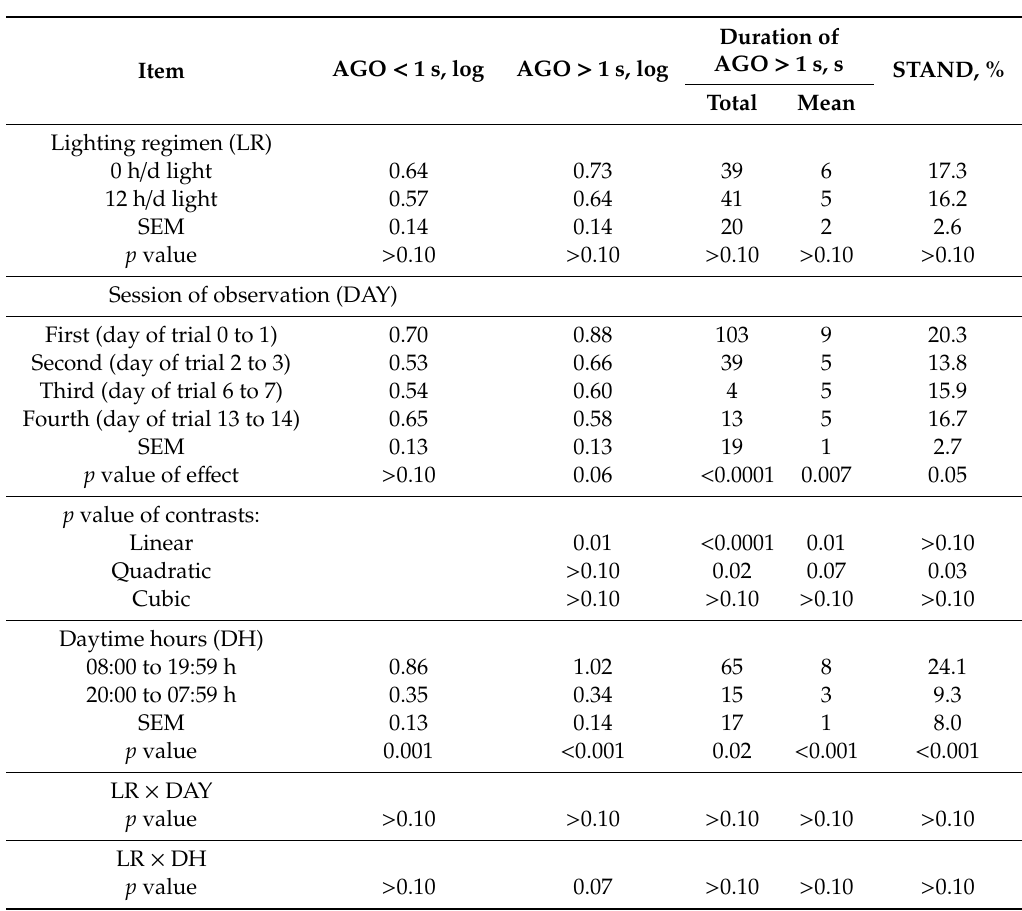
Table 3. Least squares means of the number of agonistic interactions shorter (AGO < 1 s) and longer than 1 s (AGO > 1 s), of the total and mean duration of AGO > 1 s, and of the incidence of standing pigs on total number of pigs in the pen (STAND) for lighting regimen during the first 48 h after mixing, session of observation, and daytime hours 1 .